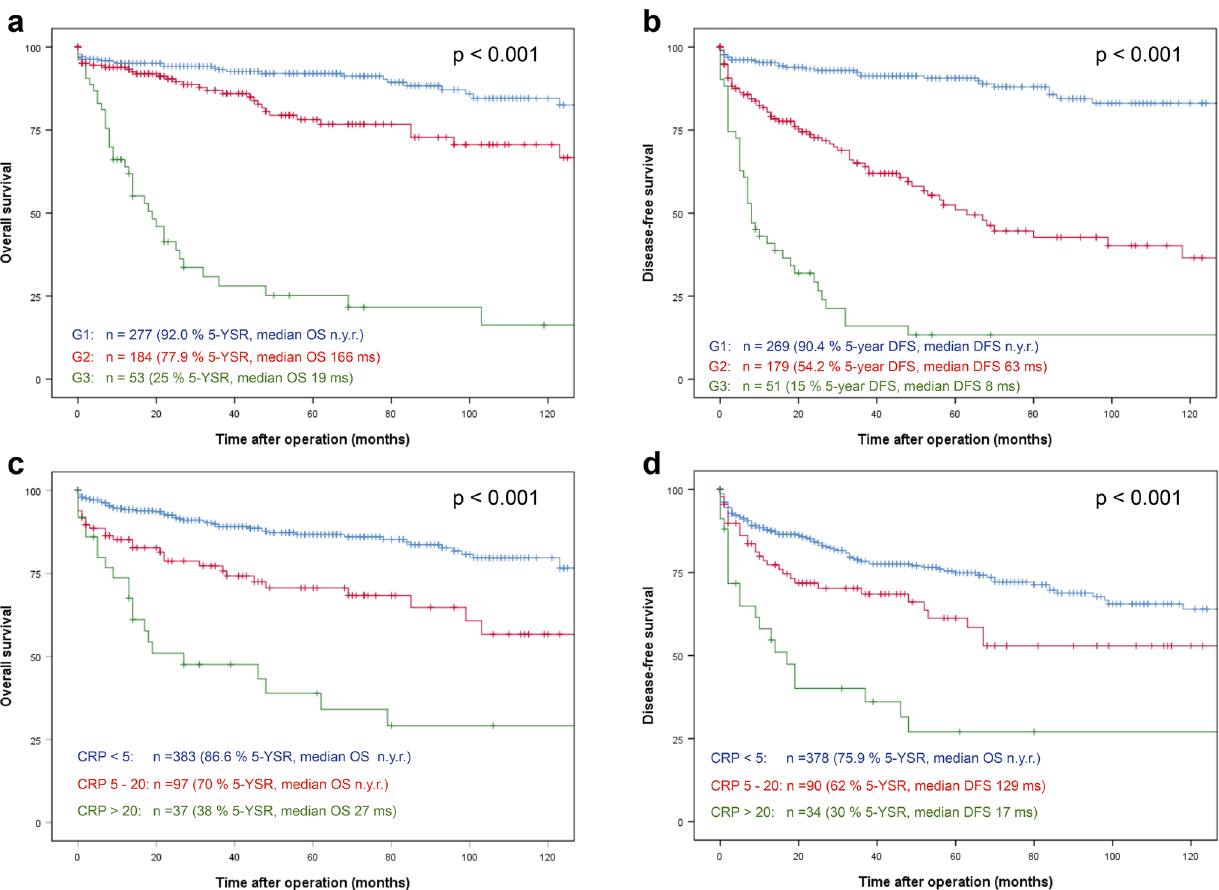
Figure 1. Postresection survival of pNEN stratified by grading and preoperative serum CRP levels. Overall (a) and disease-free (b) survival of resected pNEN stratified by grading. Overall (c) and disease-free (d) survival rate of resected pNEN patients stratified by preoperative serum CRP levels: < 5 mg/l, 5–20 mg/l and > 20 mg/l. G1: Ki-67 ≤ 2%; G2: Ki-67 3–20%; G3: Ki-67 > 20%. Patients alive at last follow-up were censored. 5-YSR 5-year survival rate, OS overall survival, DFS disease-free survival, ms months, n.y.r. not yet